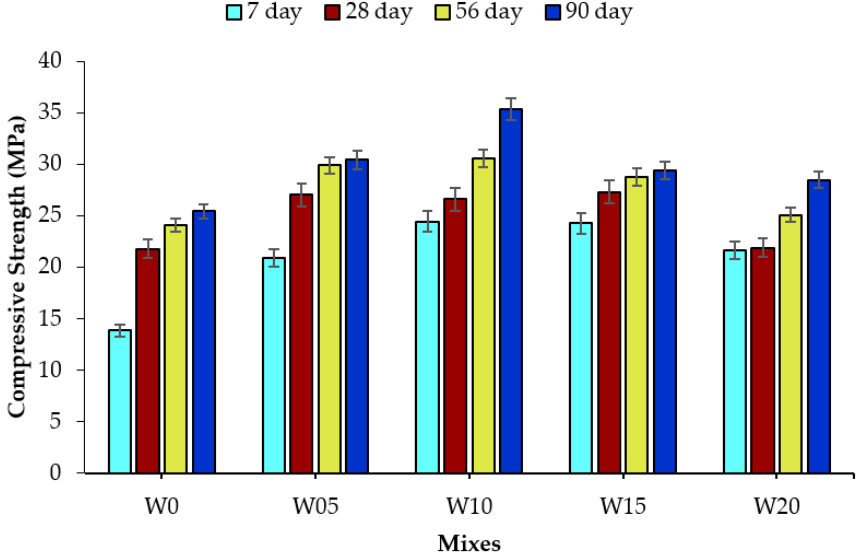
Figure 9. Compressive strength of WSA incorporated concrete mixes.